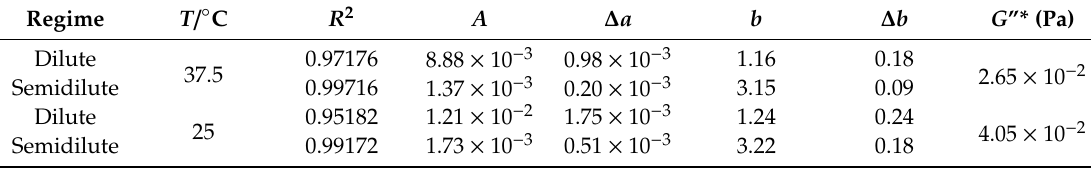
Table 1. Coe ffi cient values of equation G (cid:48)(cid:48) = a · c b related to Time Sweep experiments. Regime T / ◦